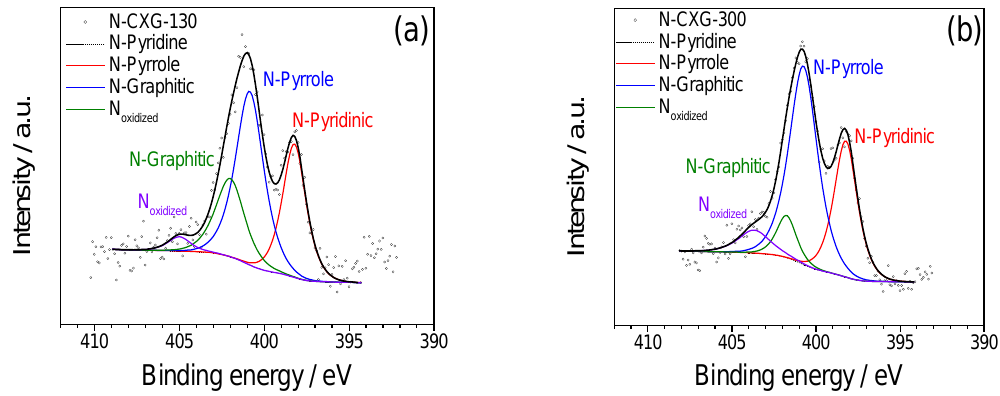
Figure 2. XPS spectra for N1s orbital for ( a ) N-CXG-130 and ( b ) N-CXG-300 xerogels.